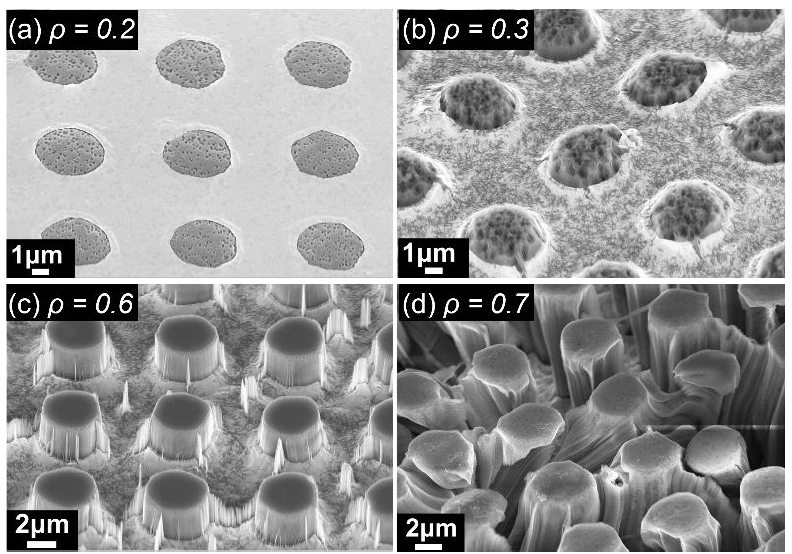
Figure 3. SEM 45° view of micropillars produced by metal assisted chemical etching in etchant with different ρ , ( a ) ρ = 0.2, ( b ) ρ = 0.3, ( c ) ρ = 0.6, ( d ) ρ = 0.7. (ρ = [HF]/[HF] + [ H 2 O 2 ], [HF] and [H 2 O 2 ] are respectively the molar concentration of HF and H 2 O 2 in moles per liter; [H 2 O 2 ] = 2.26 M, t = 20 min).